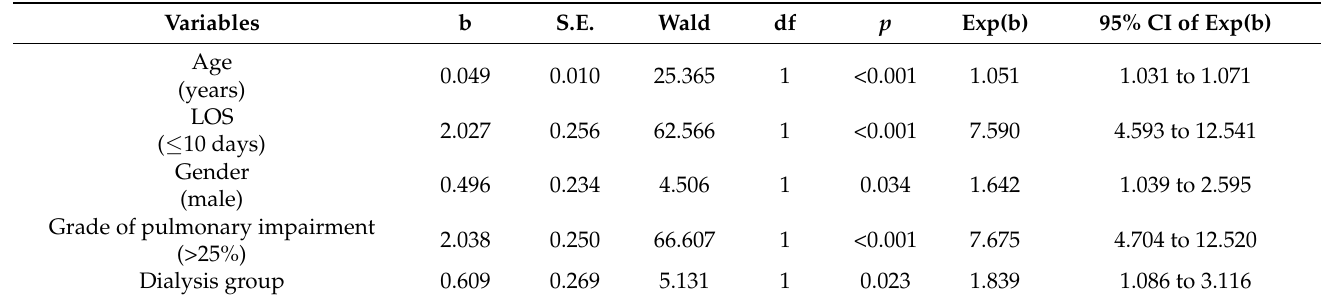
Table 3. The relative instantaneous risks of mortality in the dialysis group.